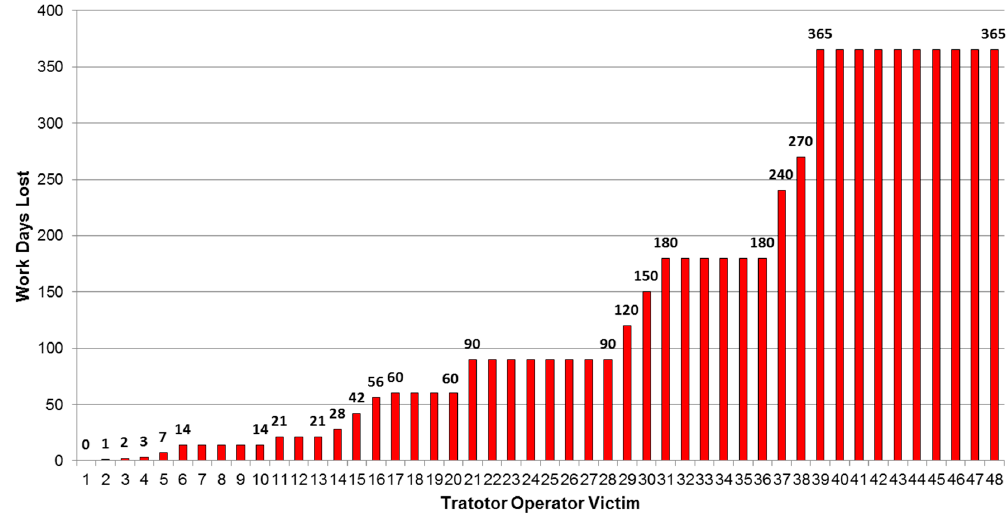
Figure 7. Operator farm workdays lost following nonfatal injuries related to non-ROPS tractor overturns, n = 48. Table 6. Details of nonfatal non-ROPS tractor overturns by chore category, n = 64. Chore Category No.